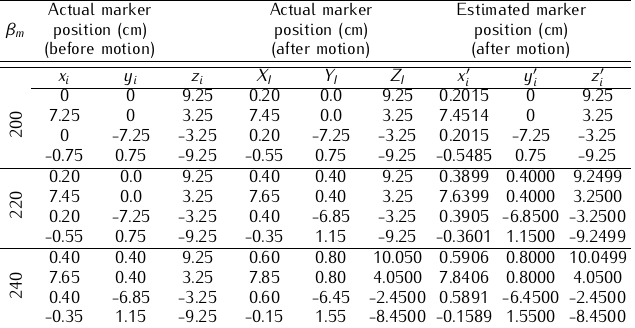
Table 7. Estimated Markers Coordinates after Translational Motion. Table 8. Comaprisons of estimated and actual motion pa-